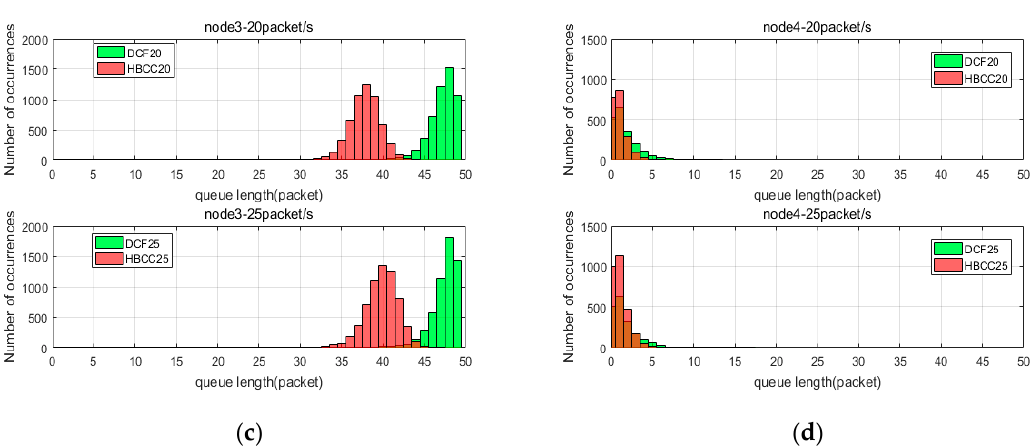
Figure 10. Bu ff er queue distribution of nodes when loads are 20 and 25 packets / s. ( a ) Node0; ( b ) Node1; Figure 10. Buffer queue distribution of nodes when loads are 20 and 25 packets/s. ( a ) Node0; ( b ) ( c ) Node3; ( d ) Node1; ( c ) Node3; ( d ) Node4.